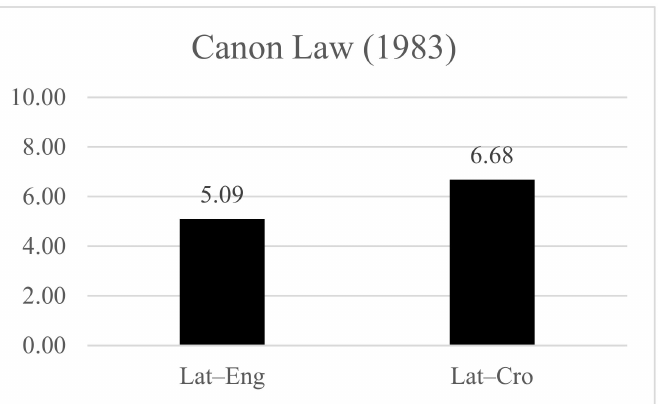
Figure 3. HHI scores for the translation terminology of the Canon Law (1983), showing higher scores for the translation into the Croatian